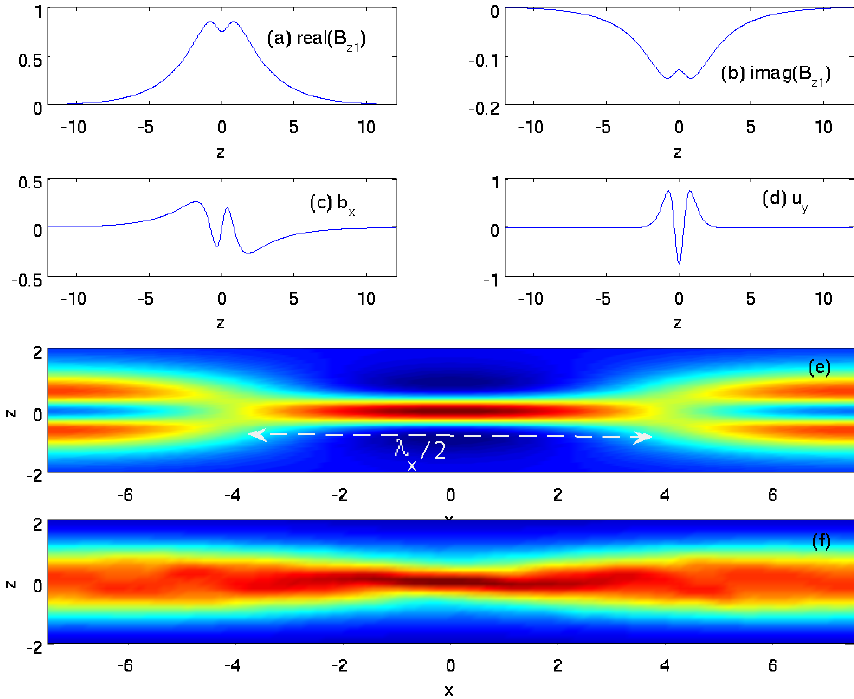
Fig. 3. The real (a) and imaginary (b) parts of the eigen function B z1 and the z -dependence of ˜ B x (x,z) (c) and ˜ v y (x,z) (d) . The panel (e) shows the structure of the CS when perturbed current density ˜ J y (x,z) = −˜ v y (x,z) is added to the equilibrium current density J y0 = sech 2 (x/L) , while the bottom panel (f) shows the CS structure in the linear stage of the